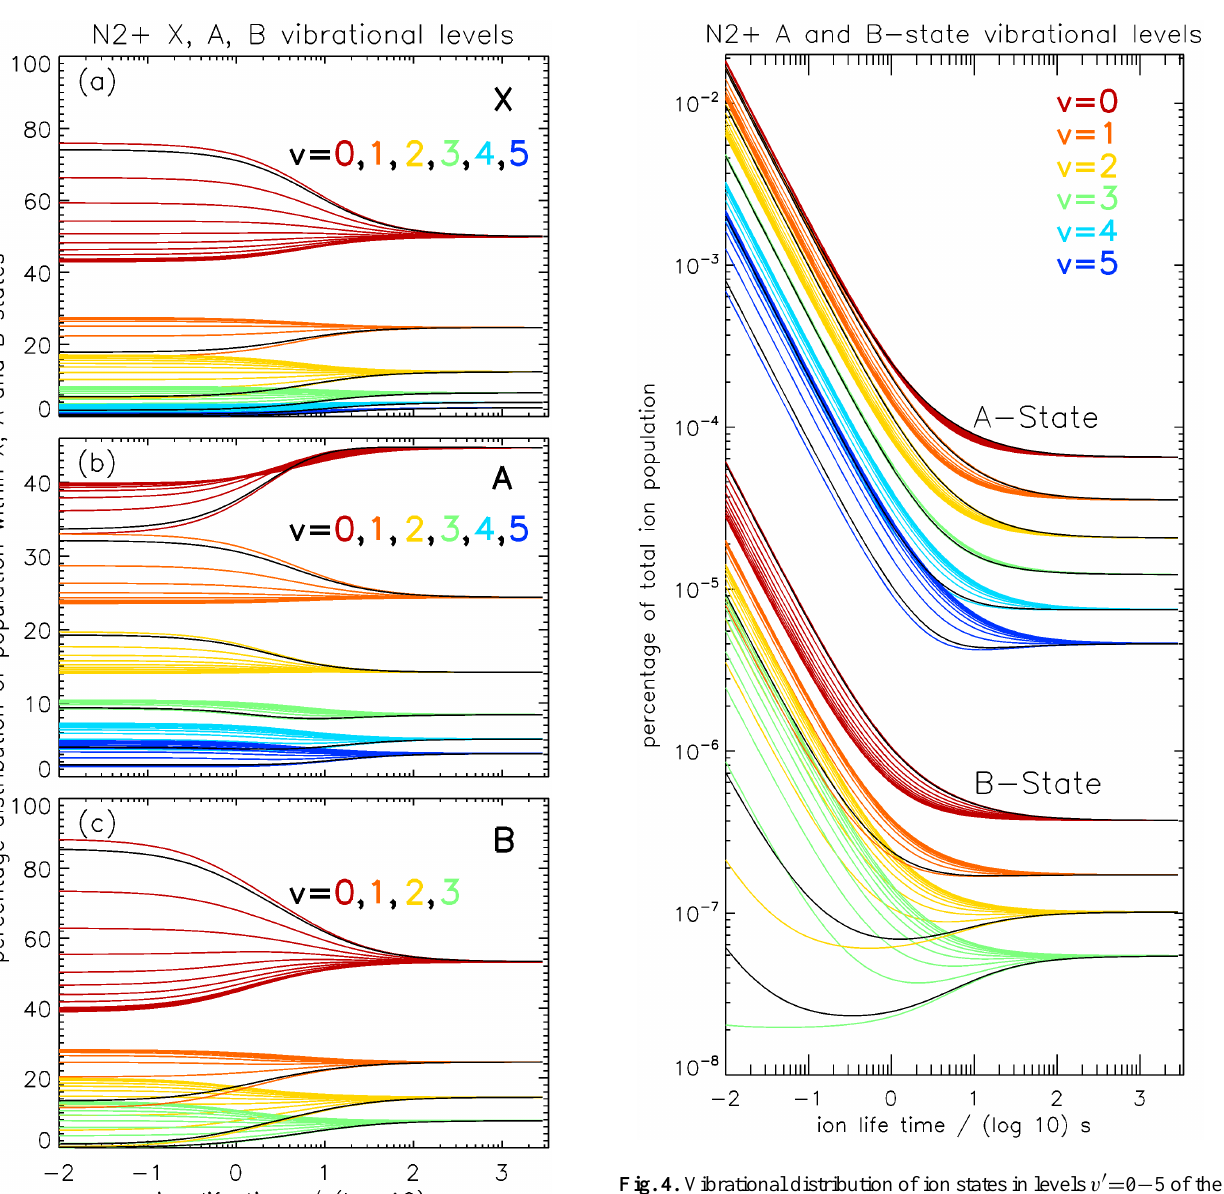
Fig. 4. Vibrational distribution of ion states in levels v 0 = 0 − 5 of the N + A state and vibrational levels v 0 = 0 − 3 of the N + 2 respect to the total population in all X, A and B states as a function Fig. 3. Vibrational distribution of ion states as a function of of ion chemical lifetime. T vib = 100 − 10000K in steps of 1000K ion chemical lifetime, for T vib = 100 − 10000K in steps of 1000K with T vib = 1000 highlighted in ( T vib = 1000 is highlighted in black and is very close to T vib = 100): (a) v 00 = 0 − 5 for N + X, (b) v 00 = 0 − 5 for N + A and (c) v 00 = 0 − 3 for 2 2 N + B. 2